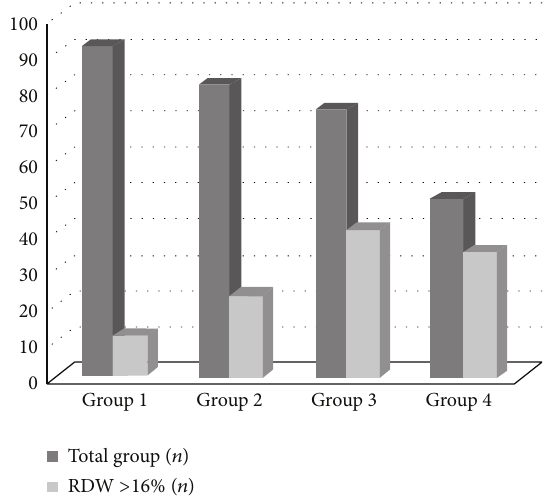
Figure 1: Distribution of patients with elevated red cell distribution width (RDW) in study